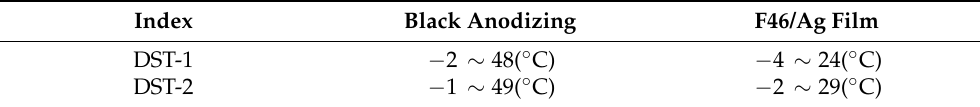
Table 4. The temperature changes of black anodizing process and F46/Ag film in an orbital